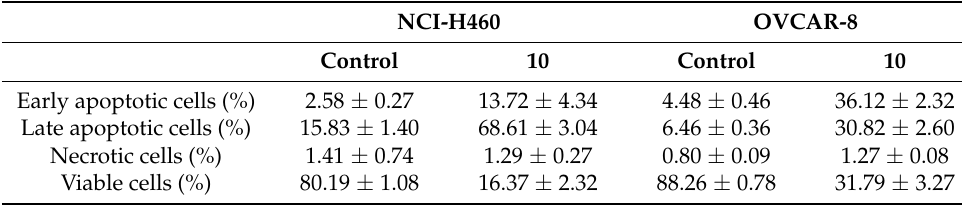
Table 2. Apoptosis measured by Annexin V-Alexa Fluor 488/PI